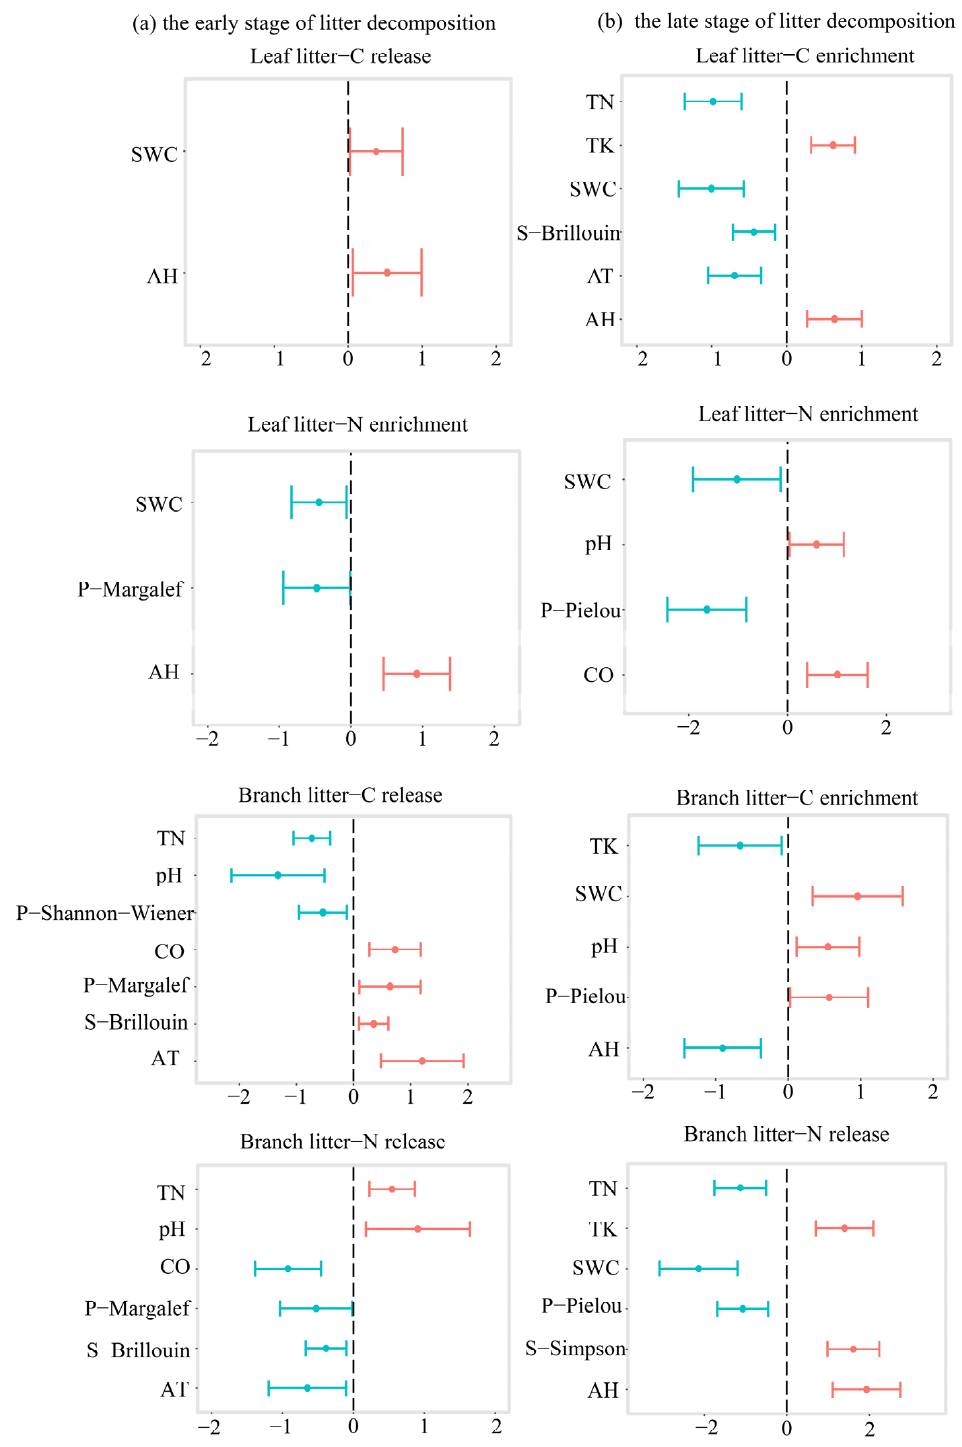
Figure 4. Generalized linear model analysis of the relationship among explanatory factors in canopy gaps and carbon and nitrogen contents of leaf and branch litter at different stages of litter decompo- sition. Notes: CO, AT, AH, TK, TN, and SWC indicate canopy openness, average air temperature, average relative air humidity, total potassium contents, total nitrogen contents of soil, and soil water content, respectively. S − Brillouin, S − Simpson indicate soil microbial Brillouin index and Simpson index, respectively. P − Shannon − Wiener, P − Pielou, and P − Margalef indicate taxonomic Shannon − Wiener index, Pielou index, and Margalef index, respectively. Horizontal coordinates represent 95% confidence intervals; red lines indicate positive effect; blue lines indicate negative